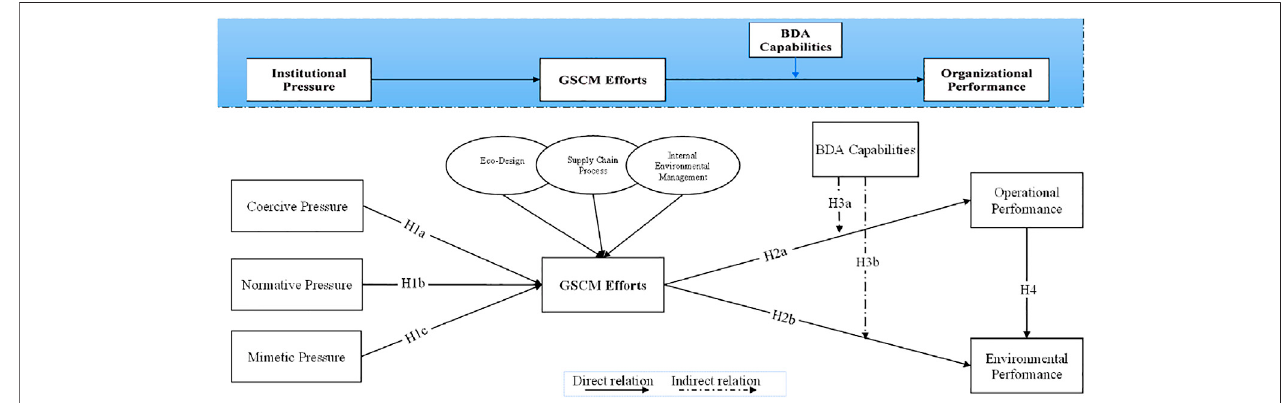
FIGURE 1 | Proposed